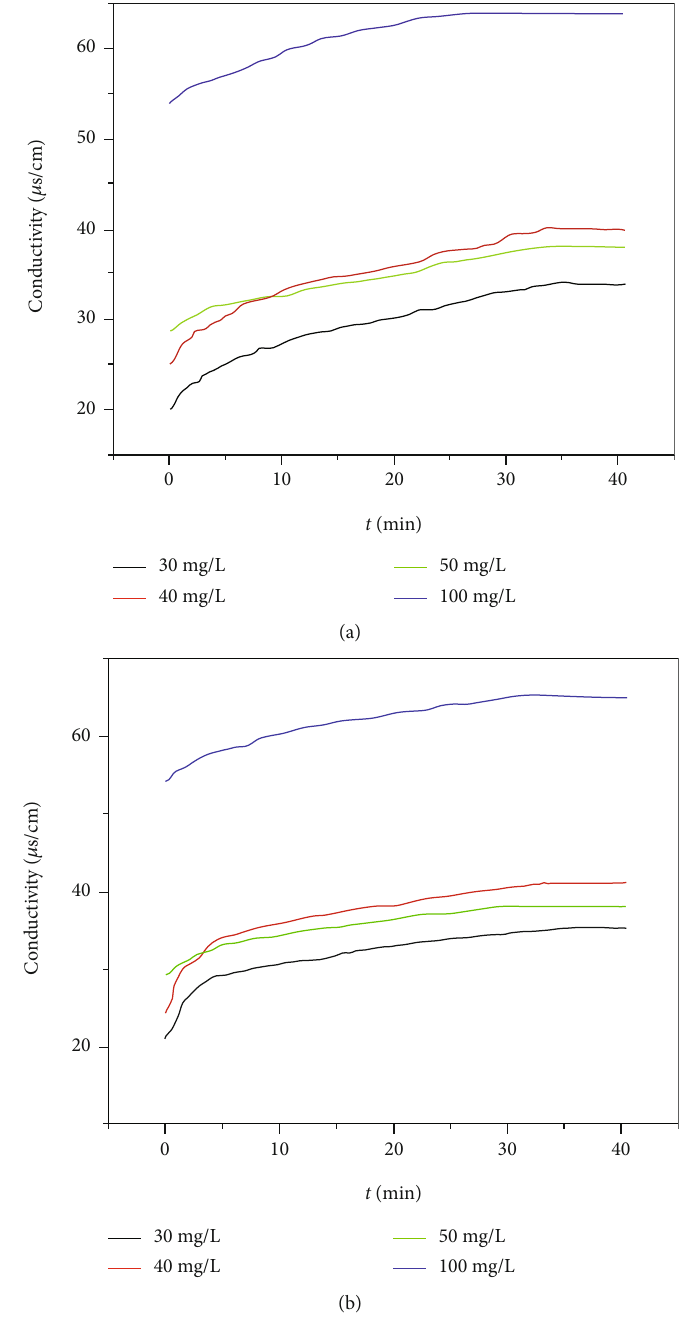
PO solutions ((a) UiO-66 (acetic acid); (b) UiO-66 2 4